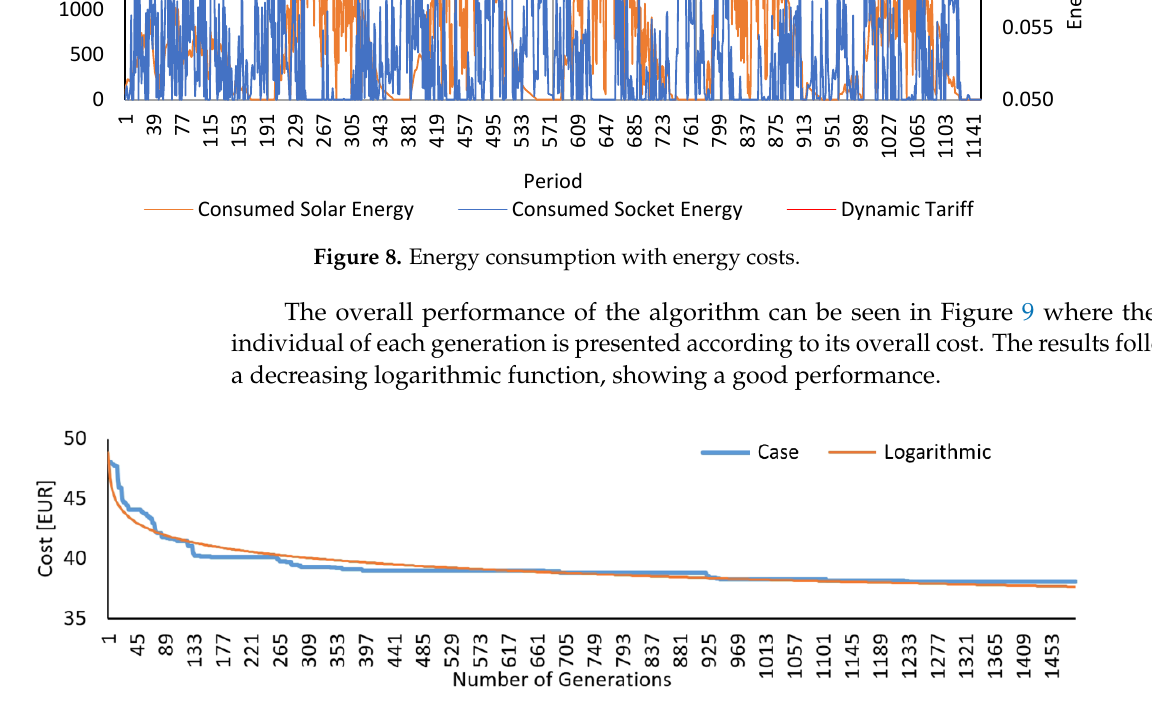
Figure 9. Cost per generation of the genetic algorithm.